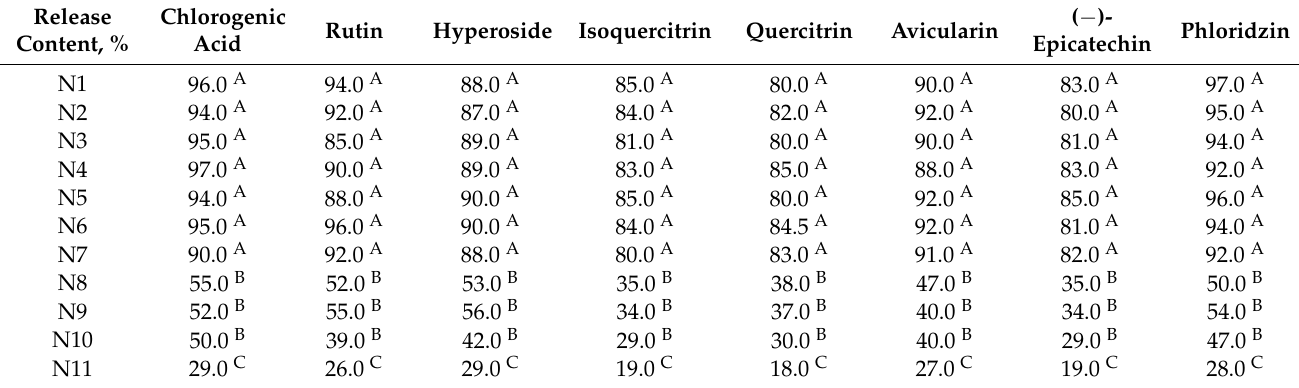
Table 3. Results of the dissolution test for phenolic compounds released from the N1–N11 capsules after 30 min. The means followed by different letters in the columns are significantly different at p <